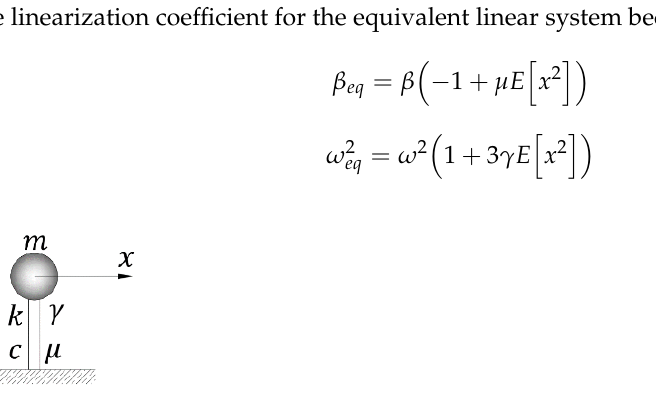
Figure 1. An SDOF Duffing – Van der Pol